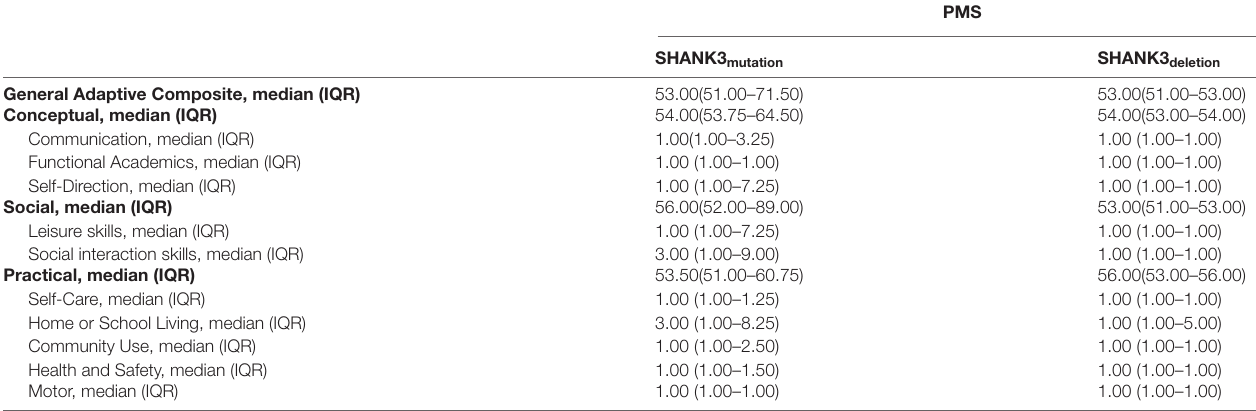
TABLE 2 | ABAS-II descriptive results according to PMS genetic defect.